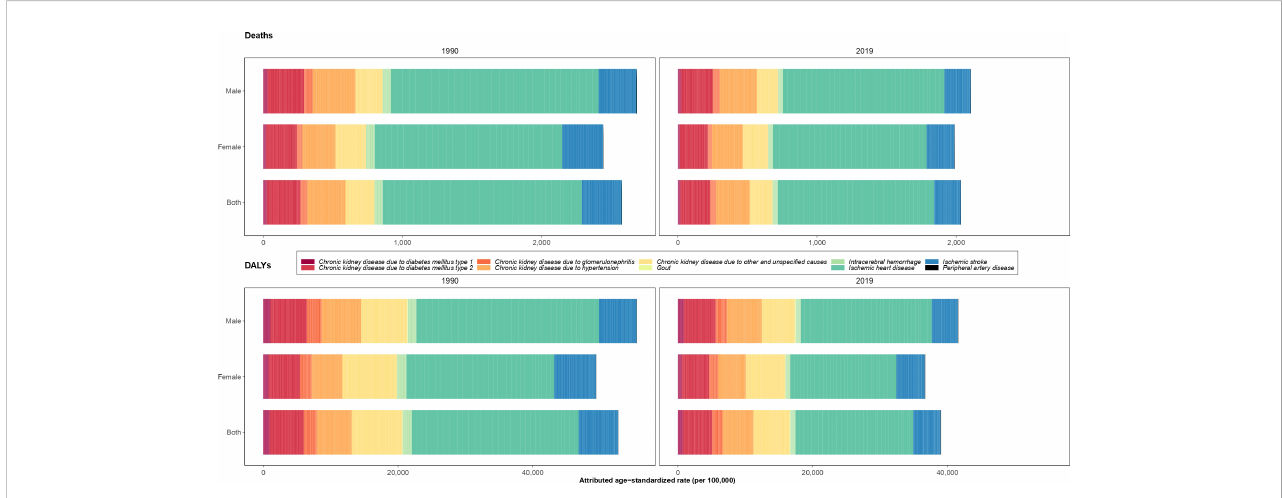
FIGURE 4 Age-standardized rate of deaths and disability-adjusted life years (DALYs) of underlying causes attributable to kidney dysfunction in 1990 and 2019 in Iran by